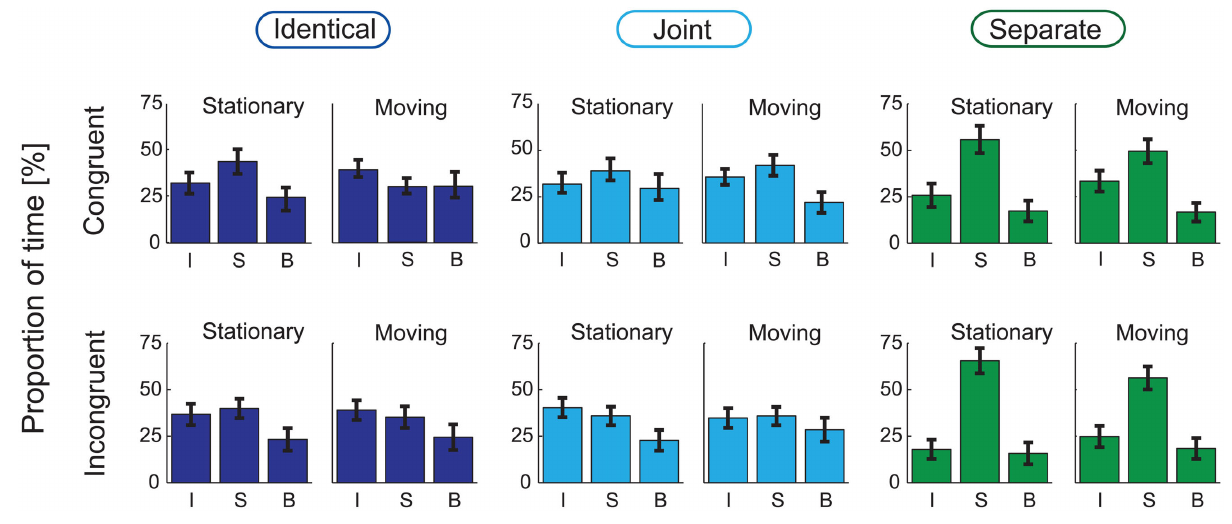
FIGURE 3 | Group-averaged ( N = 21) percentages of time of the three response alternatives (I: “Integrated,” S: “Segregated,” B: “Both”) are shown for the Identical (left panel), Joint (middle), and Separate (right) Co-locations, separately for the Stationary